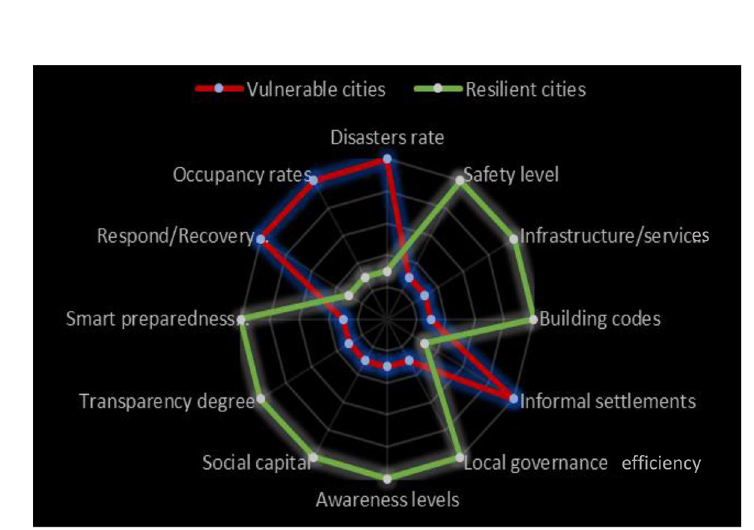
Fig. 5 Resilient and vulnerable cities